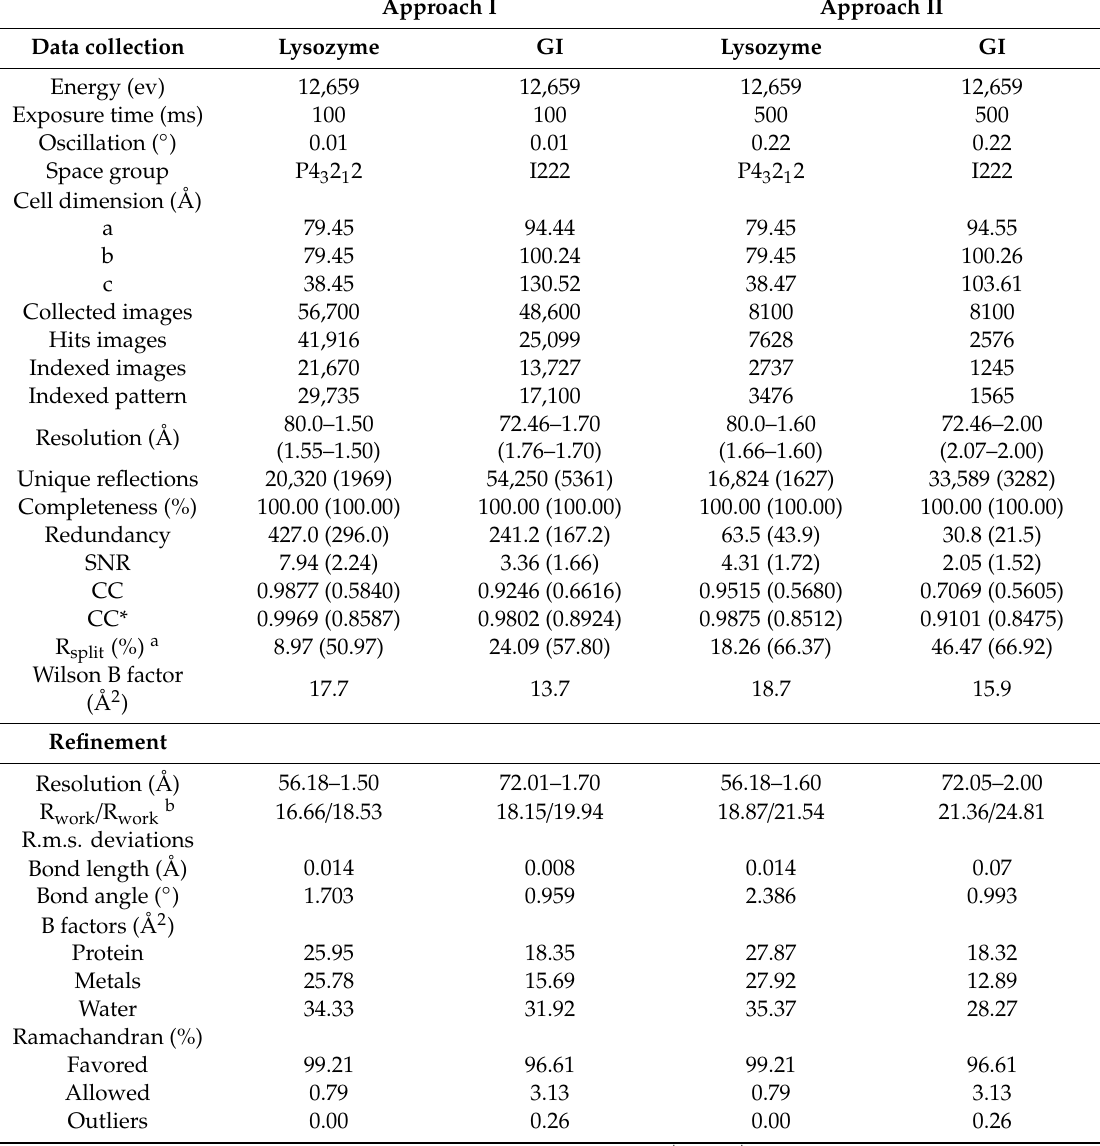
Table 1. Data collection and refinement